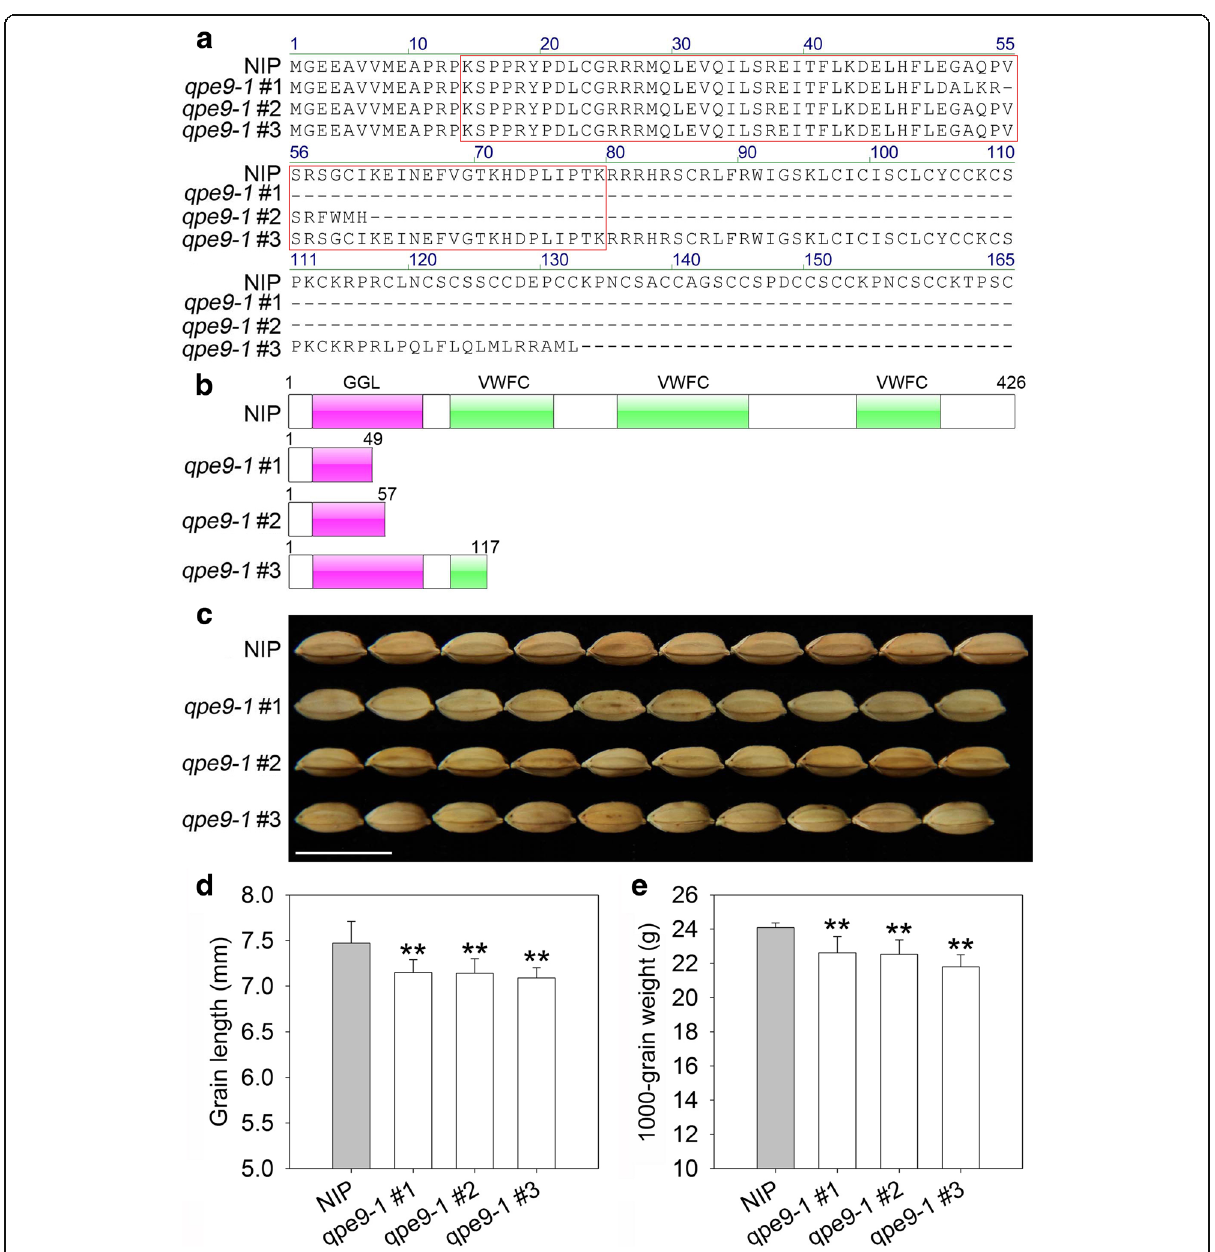
Fig. 2 Gene editing of qPE9 – 1 led to small grains in the Nipponbare background. a Protein sequences of qPE9 – 1 in the NIP, qpe9 – 1#1 , qpe9 – 1#2 , and qpe9 – 1#3 plants. The GGL domain is shown by red boxes. b Structure of the qPE9 – 1 protein in NIP, qpe9 – 1#1 , qpe9 – 1#2 , and qpe9 – 1#3 plants. The numbers represent the different lengths of the truncated qPE9 – 1 protein in wild-type plants and the three mutants. c Grains of wild-type plants and the three qpe9 – 1 mutants. Bar=1cm. d Comparison of grain length between NIP and the three qpe9 – 1 mutants. e Comparison of 1000-grain weight between NIP and the three qpe9 – 1 mutants. Data are shown as means ± SDs ( n =15). Student ’ s t -test: ** P